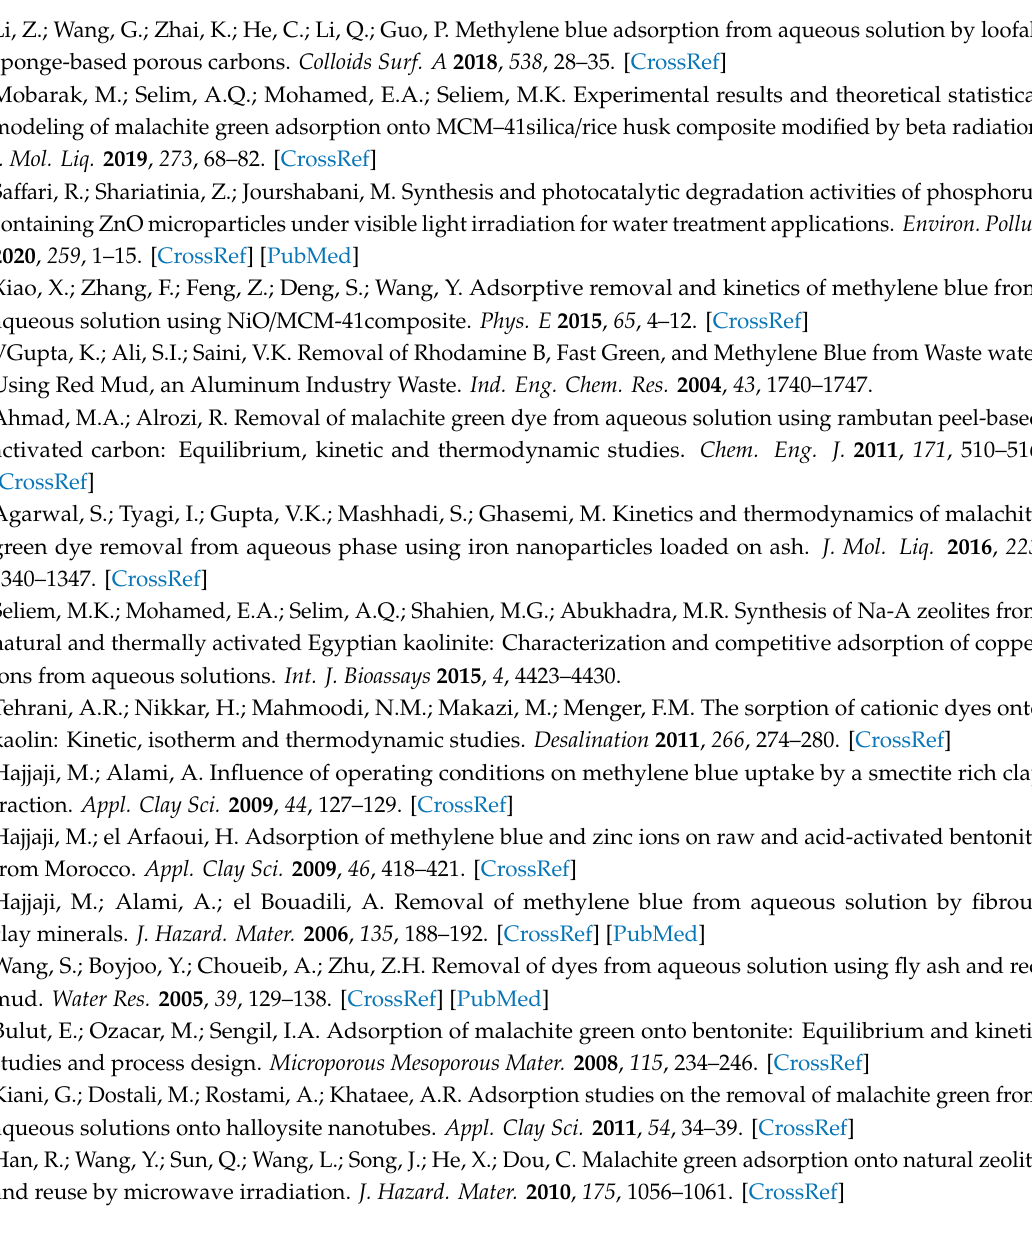
and intra-particle di ff usion model (d) on MB uptake; Figure S2: E ff ect of contact time (a), fitting of the kinetic data with pseudo-first order (b), pseudo-second order (c), and intra-particle di ff usion model (d) on MG uptake; Figure S3: The non-linear plots of the pseudo-first order and the pseudo-second order kinetic models of MB and MG adsorption onto MNP / SP composite; Figure S4: Linear Langmuir fitting (a,b), linear Freundlich fitting (c,d), and the non-linear fitting using Langmuir and Freundlich models (e,f)., Table S1: Kinetics models for dye adsorption by MNP / SP composite; Table S2: Fitting the kinetic data with di ff erent kinetic models; Table S3: Parameters of isotherms models for MB and MG uptake by MNP / SP